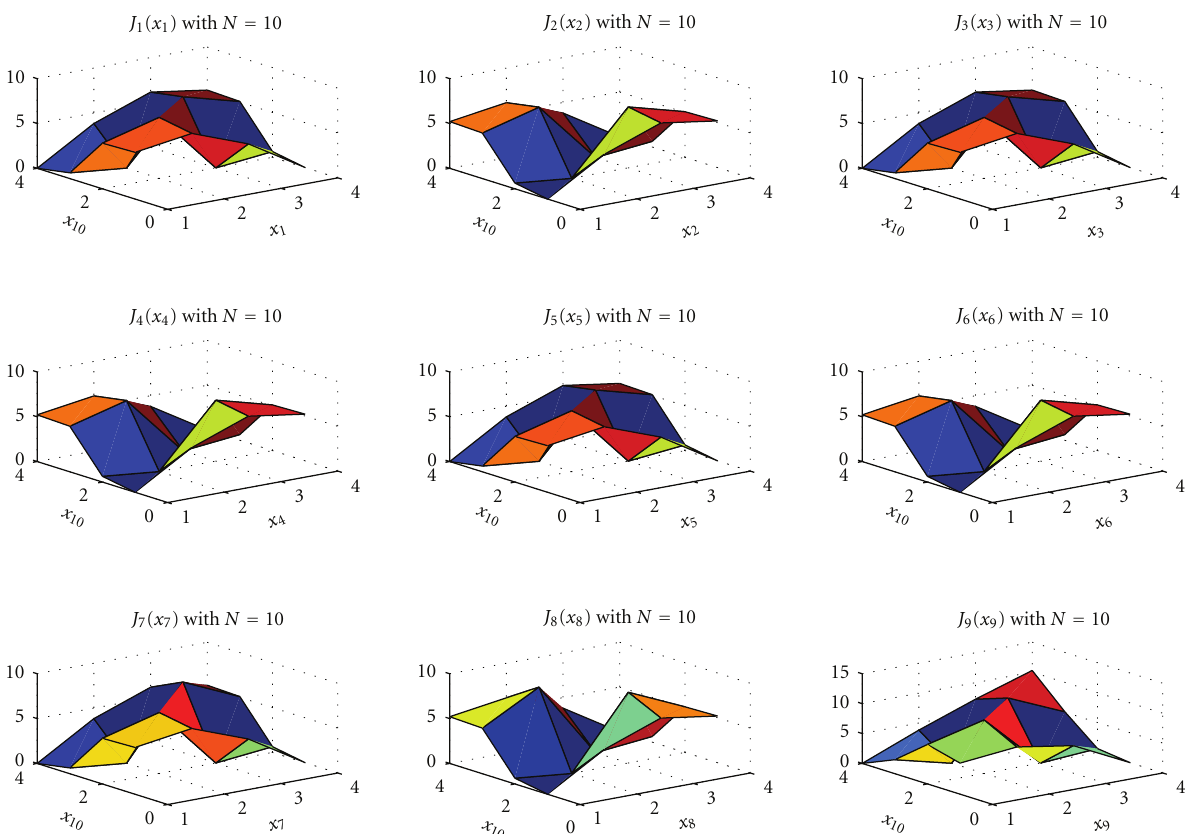
Figure 6: Graphical representation of J q , 0 ≤ q ≤ 8, N = 9, in single-base deterministic mutation example. The x -axis and y -axis represent x x d J x x d q and q ( q , N , respectively. N ) are represented by 16 isolated points. Those discrete points are connected together to show the